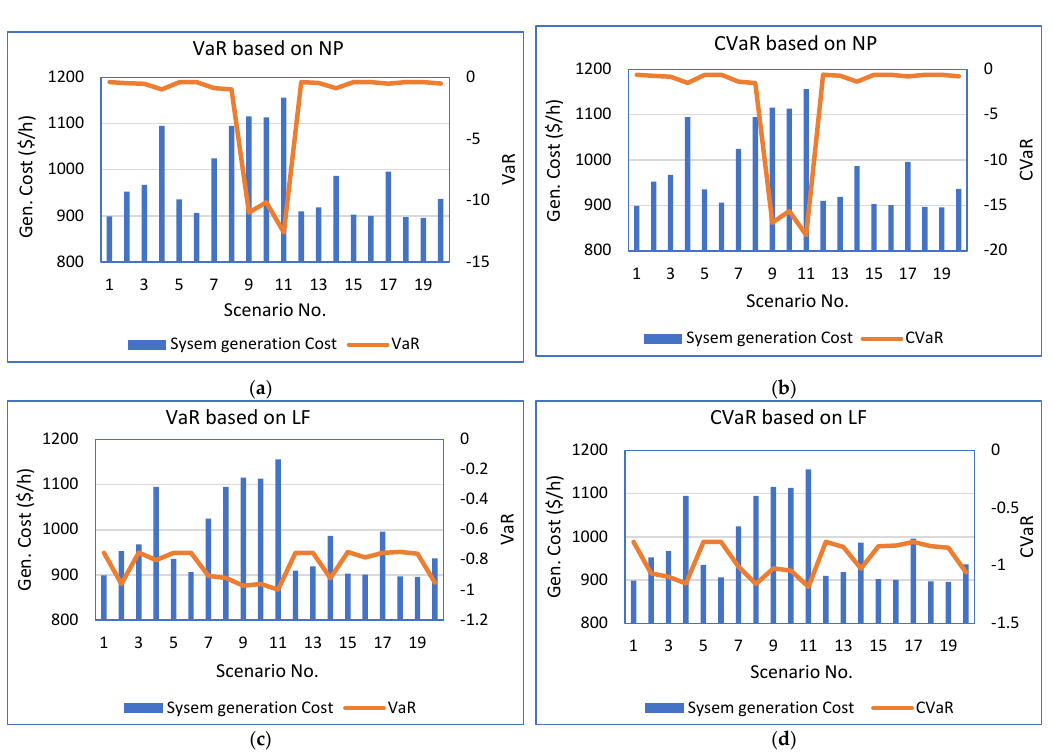
Figure 2. Relation between generation cost and risk assessment tools. VaR based on NP ( a ), CvaR basd on NP ( b ), VaR based on LF ( c ), CvaR based on LF ( d ). Step 2: System Economy (without imbalance cost) and Risk with Wind Farm Integration